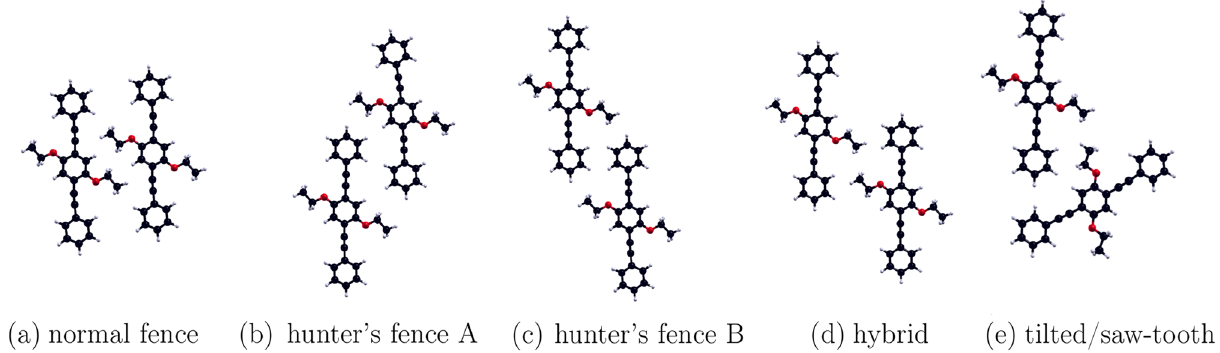
Figure 5. Prototypes for energetically most favorable pair configurations ( a ) normal fence 1.1 ( b ) hunter’s fence A 2.1 ( c ) hunter’s fence B 3.1 ( d ) hybrid 2.7 and ( e ) saw-tooth